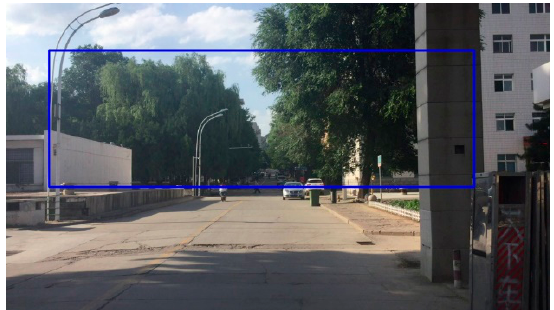
Figure 12. The ROI in this experiment.